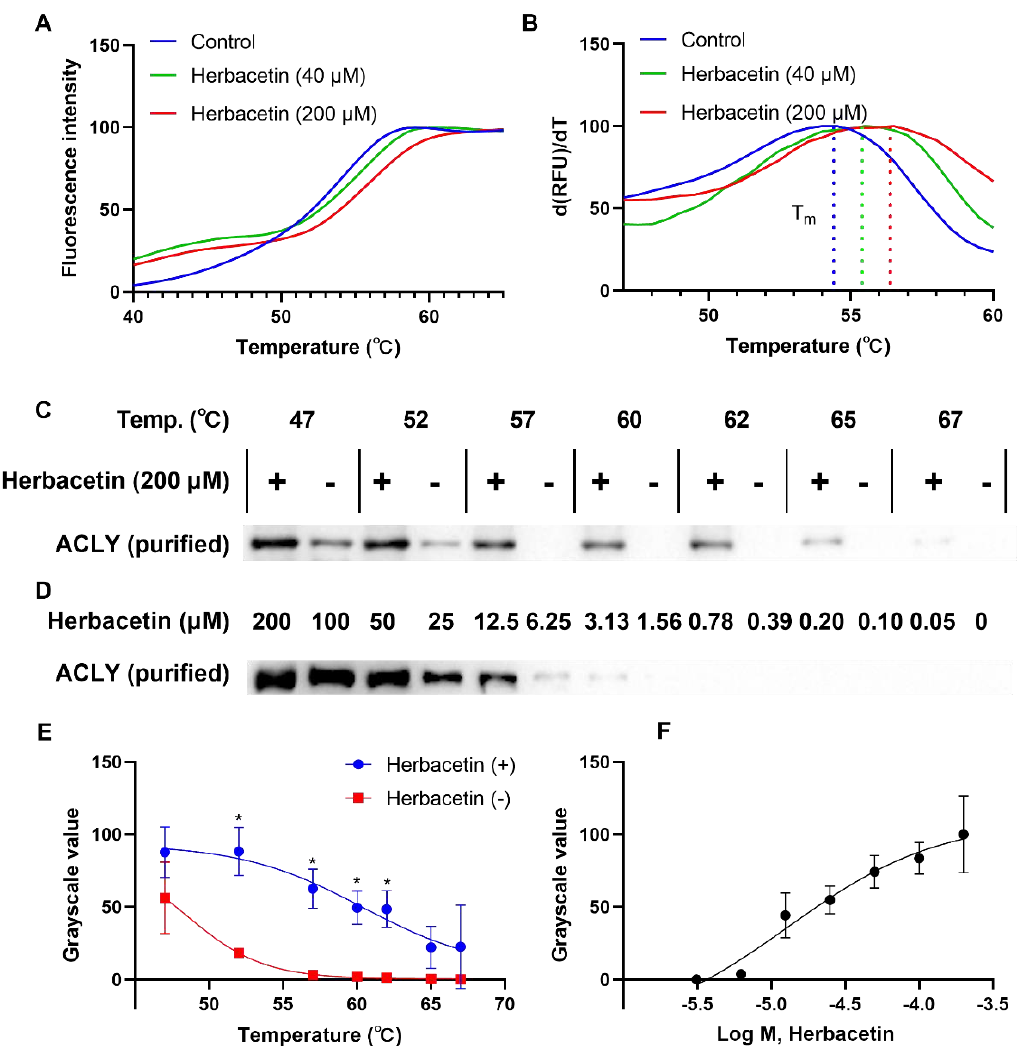
Figure 4. Effects of herbacetin treatment on thermal stability of ACLY: ( A ) melting curve of ACLY in the heating process (fluorescence was recorded by a q − PCR machine); ( B ) first derivative of ( A ), representing the changing rate of fluorescence; ( C , E ) Western blot analysis of ACLY on herbacetin treatment compared to DMSO treatment. The statistical results were two independent replicate ex-